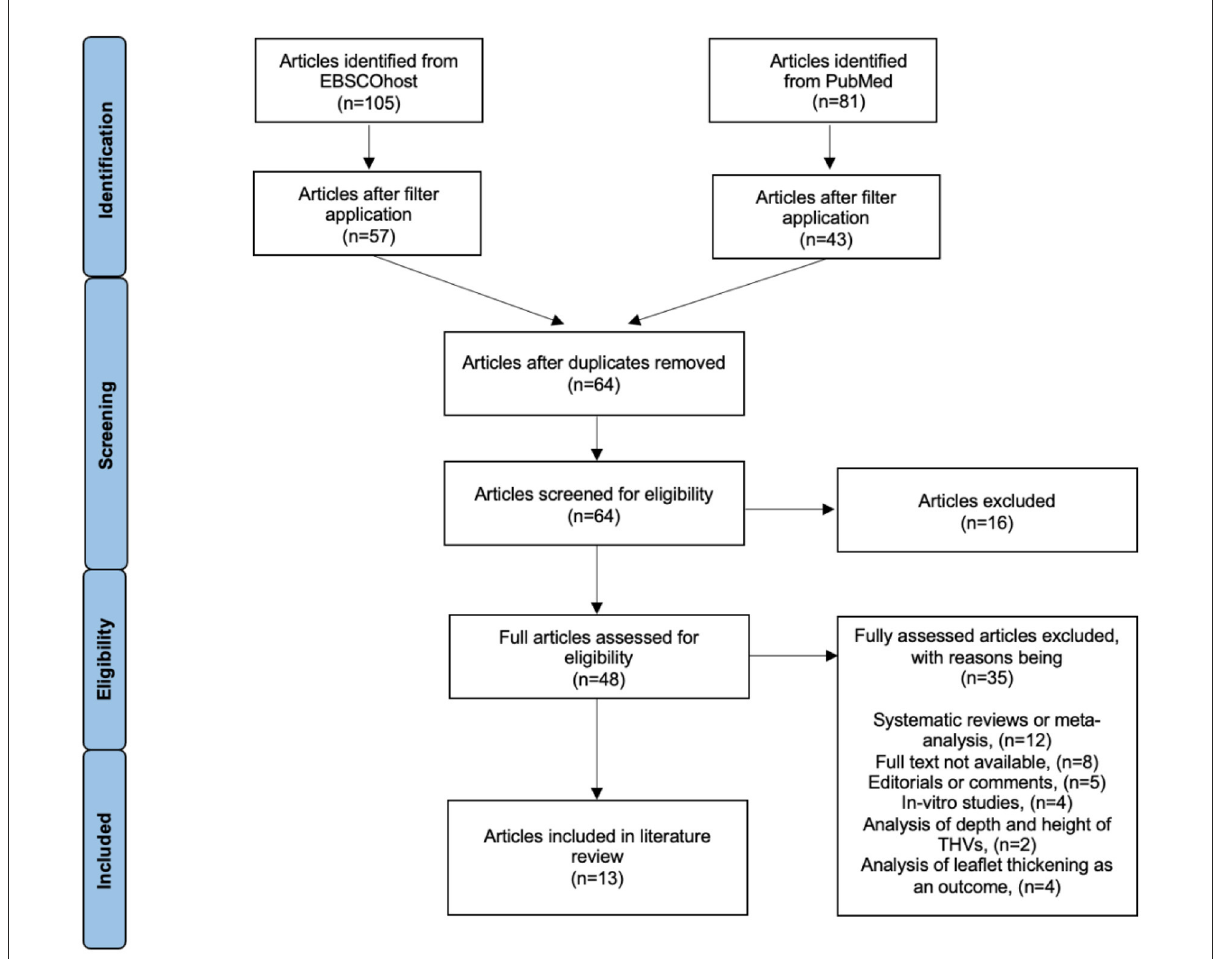
FIGURE1 PRISMA flow diagram for selection process of relevant